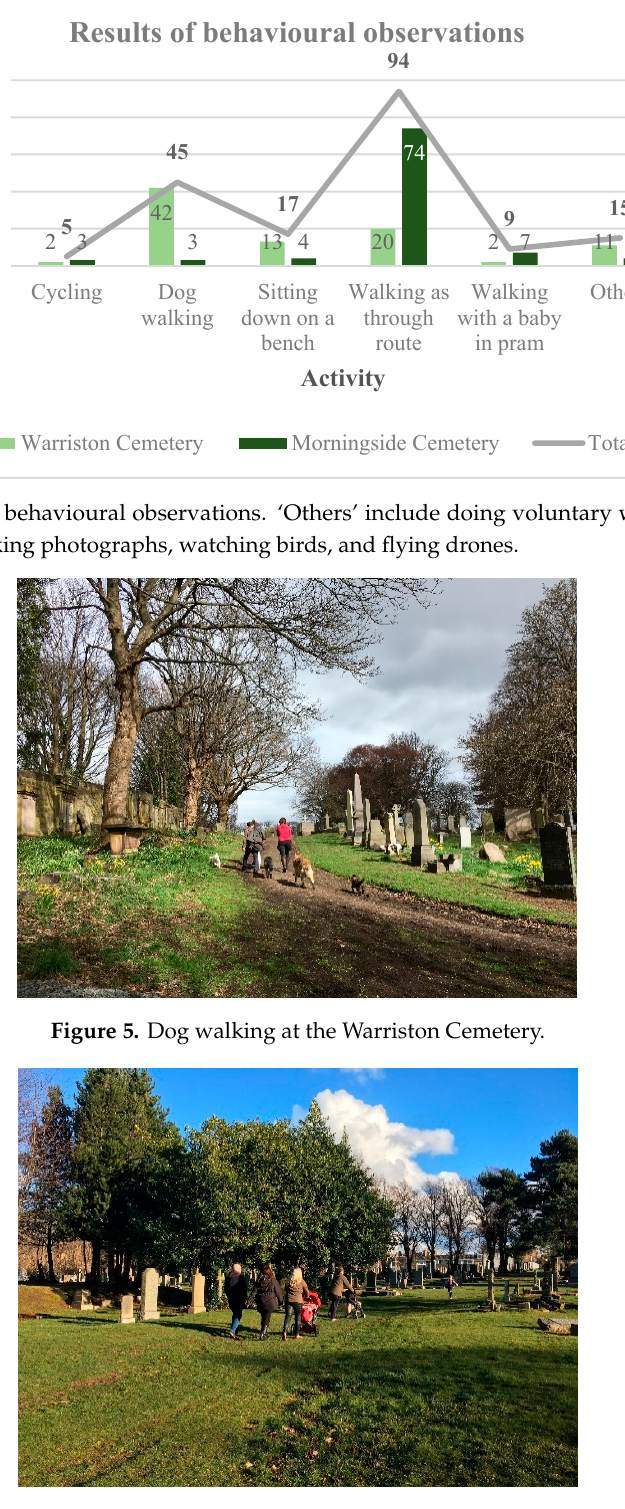
Figure 6. Walking with babies in prams at the Morningside Cemetery.